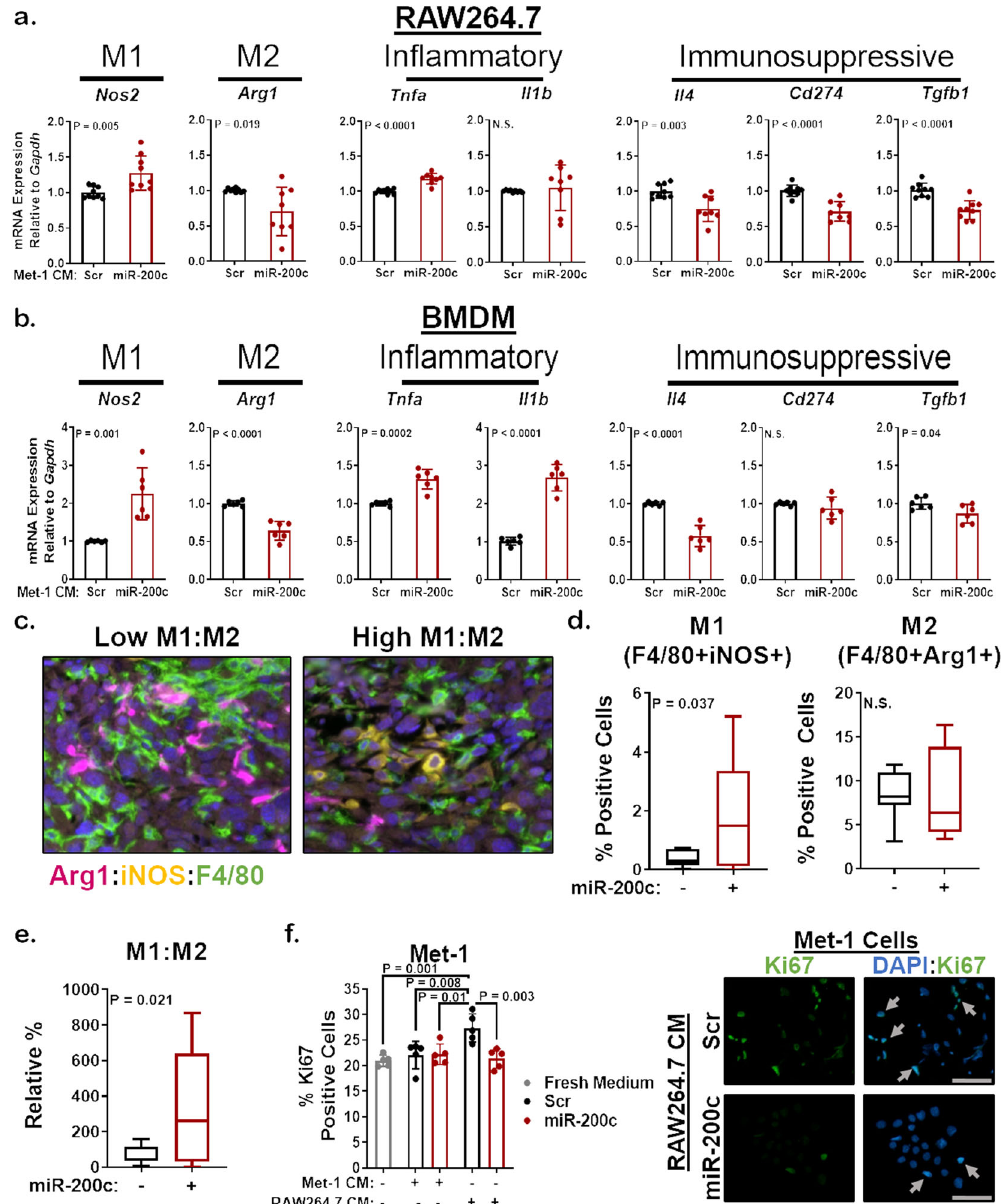
Fig. 4 Soluble factors from miR-200c-expressing mammary tumor cells enhance M1 macrophage polarization. a, b Met-1 cells were transiently transfected with miR-200c. After 96 h, Met-1 Scr or Met-1 miR-200c conditioned medium (CM) was placed on RAW264.7 cells ( a ) or bone marrow-derived macrophages (BMDM) that were previously stimulated for 5 days with 25 ng/mL M-CSF ( b ). At 48 h culture with CM, macrophage polarization was determined via qRT-PCR for M1 ( Nos2 and proin fl ammatory cytokines: Tnfa and Il1b : interleukin-1 beta/IL-1 β ) and M2 ( Arg1 : Arginase-1/Arg1 and immunosuppressive cytokines/marker: Il4 : Interleukin-4/IL-4, Cd274 : programmed death-ligand 1/PD-L1, Tgfb1 : transforming growth factor- β 1/TGF- β 1) genes. Shown is the mean mRNA expression relative to Gapdh of 2 – 3 experiments conducted in triplicate ± s.d., N = 6 – 9, Student ’ s unpaired two-tailed t test. c – e M1 and M2 macrophage polarization was determined using opal multiplex fl ours on FFPE Met-1 TripZ-200c tumors. Images were scanned and analyzed using the Vectra Microscope and InForm Software. Representative fi elds from the same tumor with a low or high M1:M2 ratio are shown at 20× (magenta = Arg1, yellow = iNOS, green = F4/80, blue = DAPI, c ). The percent M1 macrophages (F4/80 + iNOS + cells/total cells, d — left), percent M2 macrophages (F4/80 + Arg1 + cells/total cells, d — right), and the ratio of M1:M2 macrophages ( e ) across 3 – 5 fi elds/tumor is shown as a box plot with the center line representing the median, the box representing the 25th and 75th percentiles and the whiskers representing the minimum and maximum, N = 7 – 11, Welsh ’ s unpaired two-tailed t test. f Shown is the mean percent Ki67-positive nuclei for Met-1 cells cultured with fresh culture medium (gray), CM from Met-1 cells transfected with miR-200c as described in ( a ) or CM from RAW264.7 cells that were polarized to more M2 or M1-like by CM from Met-1 Scr or miR-200c cells, respectively. Shown is the mean of fi ve fi elds from 2 – 3 separate experiments ± s.d., N = 9 – 15, Student ’ s unpaired two-tailed t test (left). Representative images are shown on the right, 10×, scale bar = 100 µM (arrows denote Ki67-positive cells).